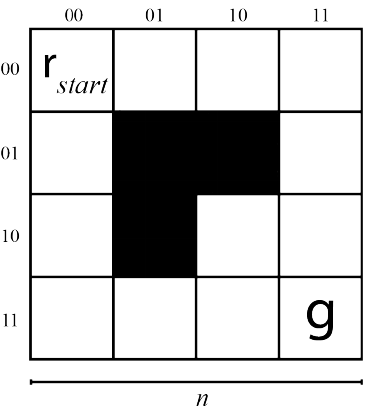
Figure 13. The 4 × 4 map, the starting point has been placed in the left upper corner, the target position g is in the right bottom corner.